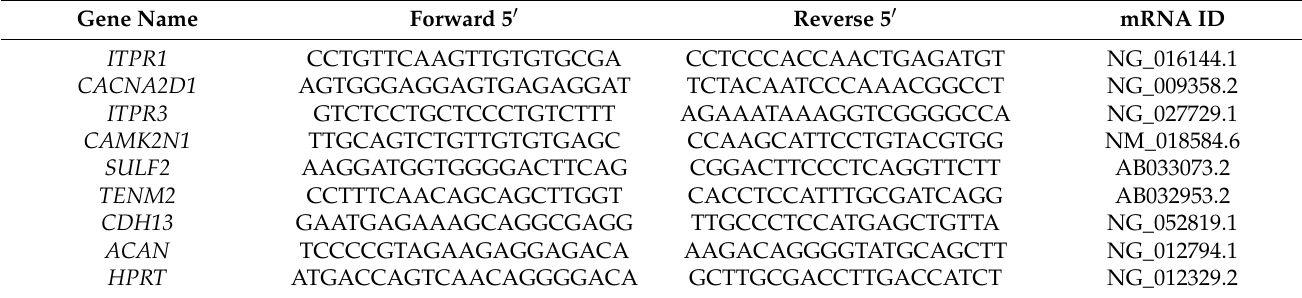
Table A2. Primers for real-time reverse transcriptase-polymerase chain reaction (qRT-PCR) amplification.